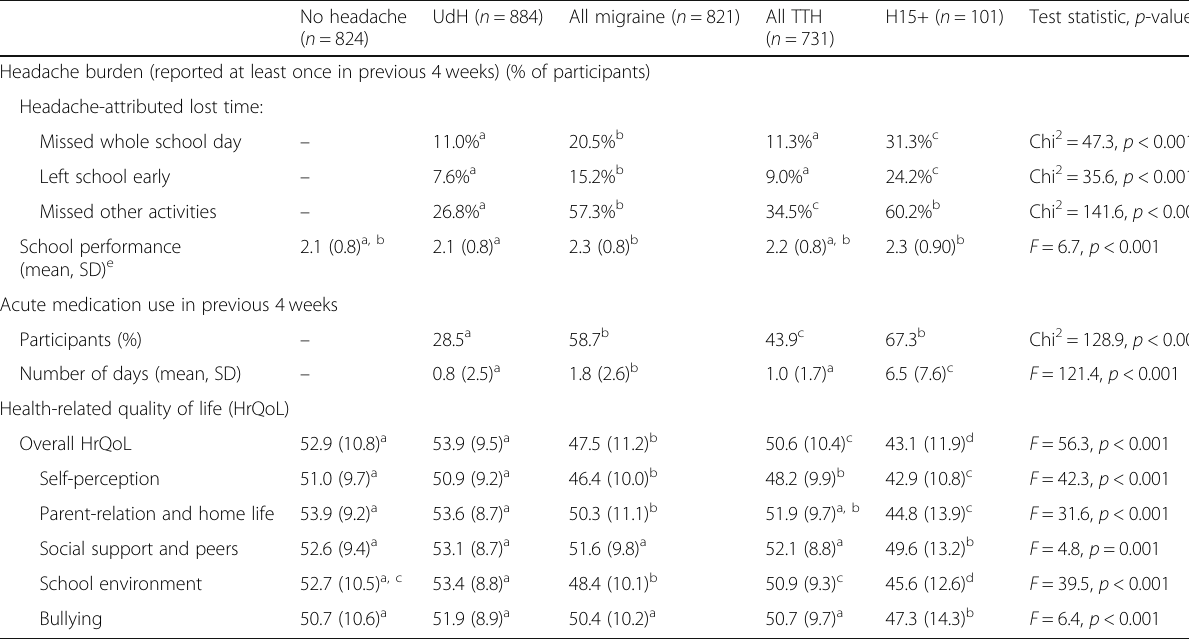
Table 5 Burden of headache, acute medication use and health-related quality of life by headache diagnosis ( N = 2562)